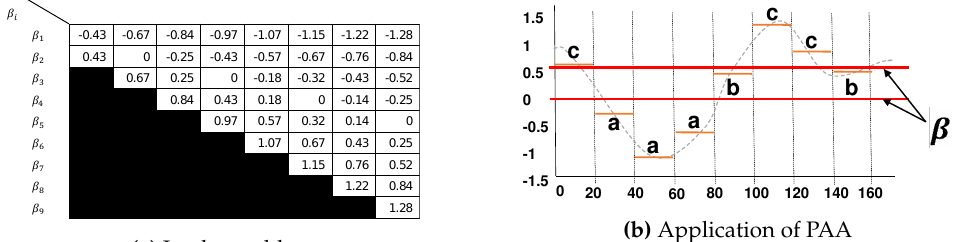
Figure 2. ( a ) The lookup table shows the breakpoints that divide the Gaussian distribution into an arbitrary number of equiprobable regions. ( b ) The application of the PAA in a time series (N = 160) resulting in a new signal (M = 8). The new signal is composed of all values ¯ t i , which are computed at each